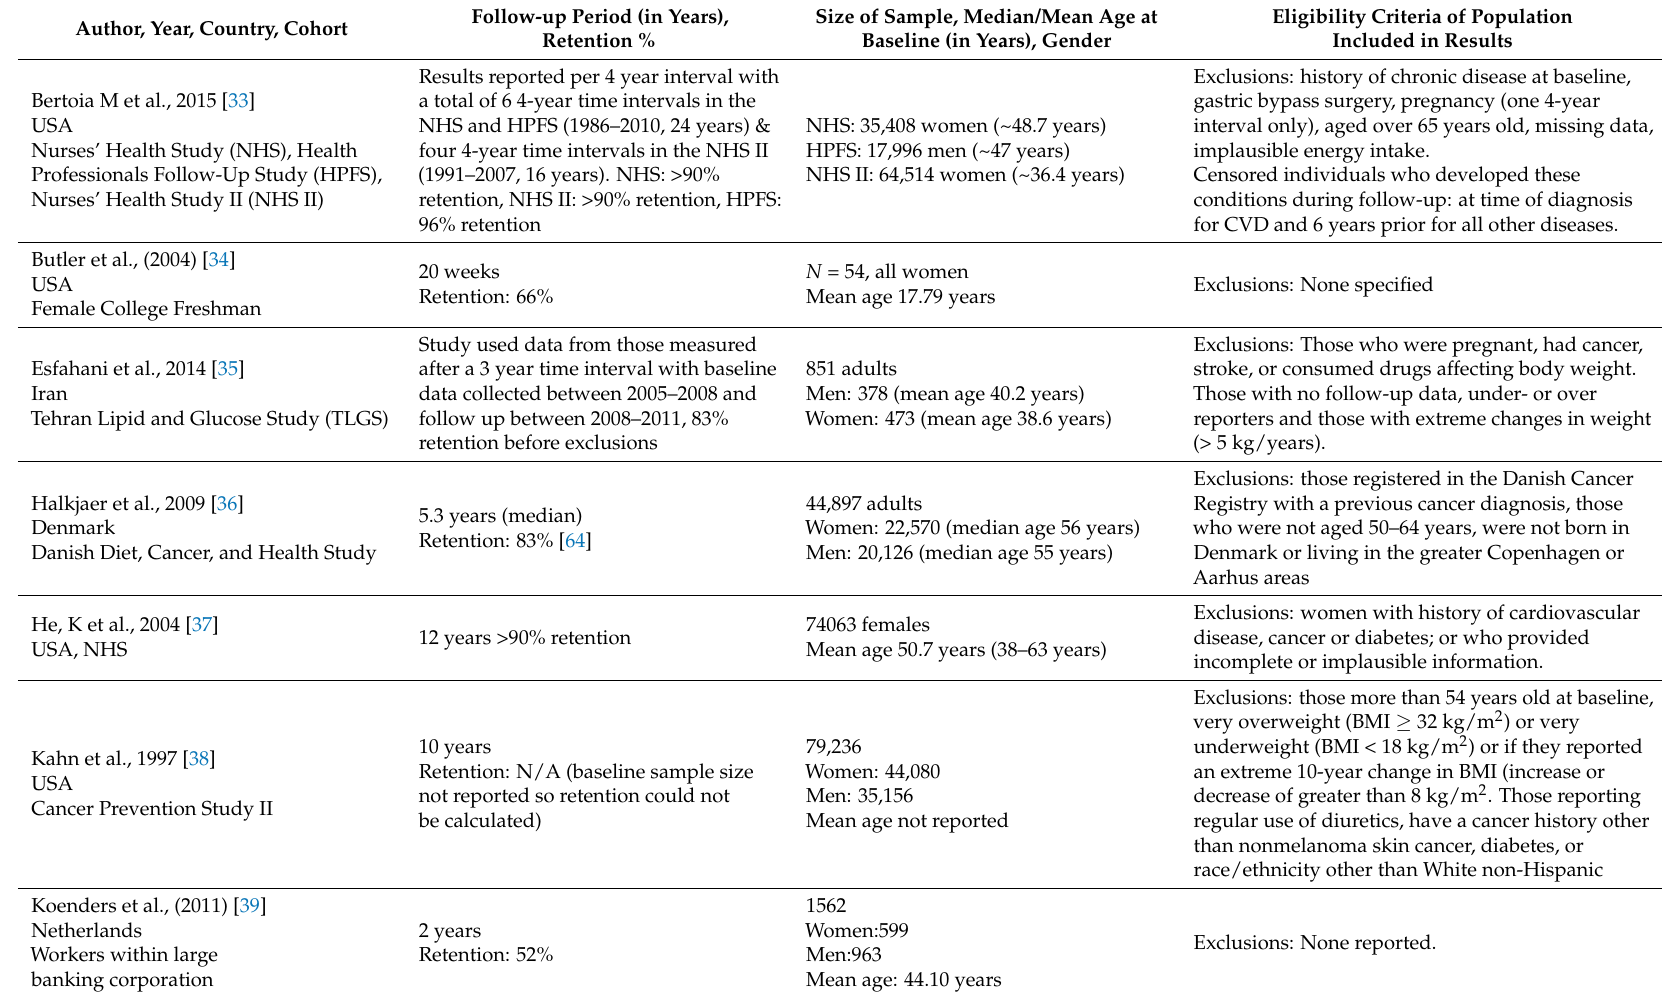
Table 4. Characteristics of studies including country, population demographics, sample size, eligibility criteria, duration of study, and